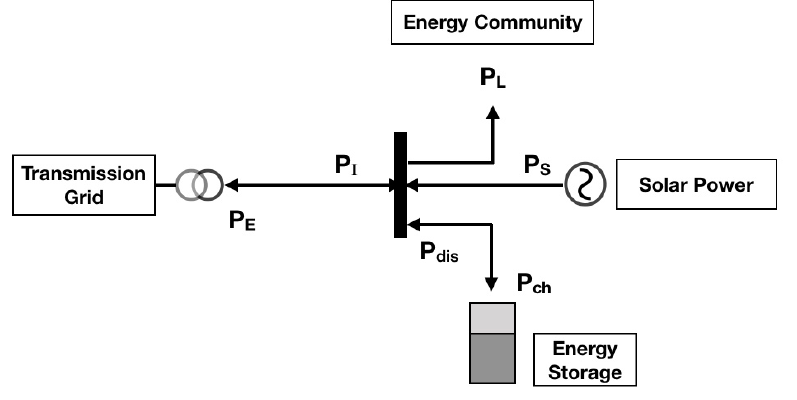
Figure 2. Physical Structure.